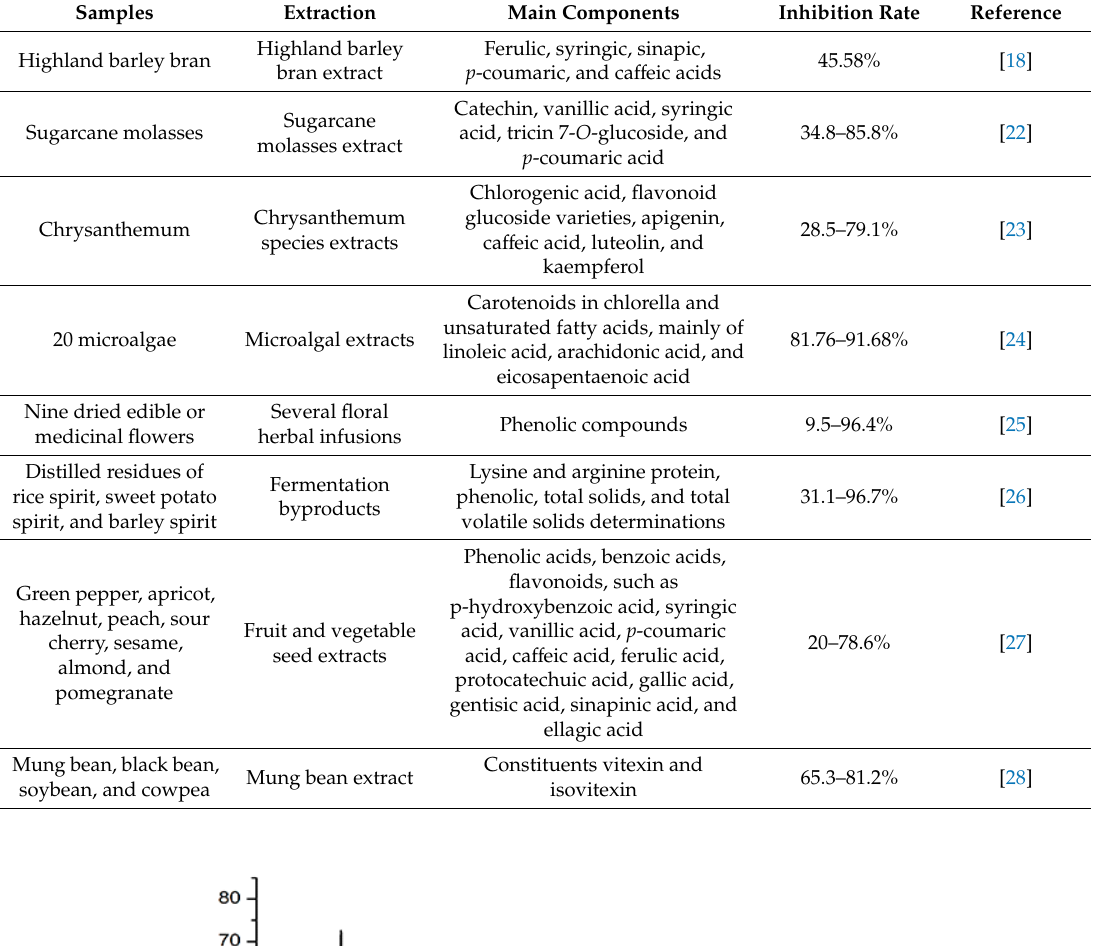
Table 1. Summary of literature reports on CML inhibition by di ff erent substances.